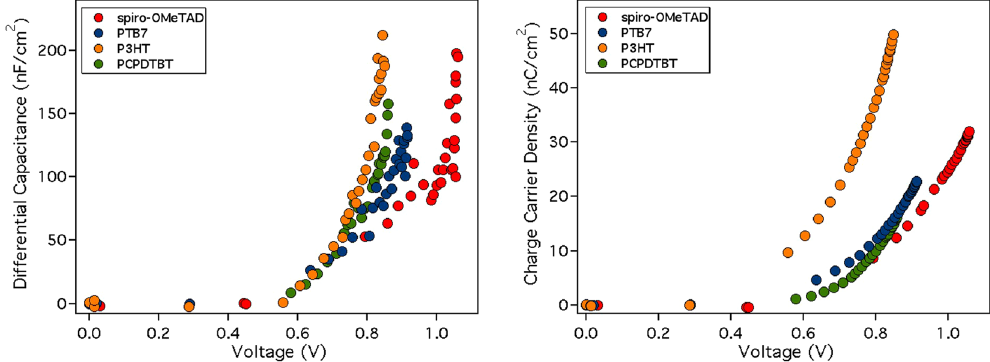
Figure 8. (Left) Capacitance at different voltages (light bias) after subtracting the geometrical capacitance and (right) the charge obtained upon integration of the capacitance at the same voltages.